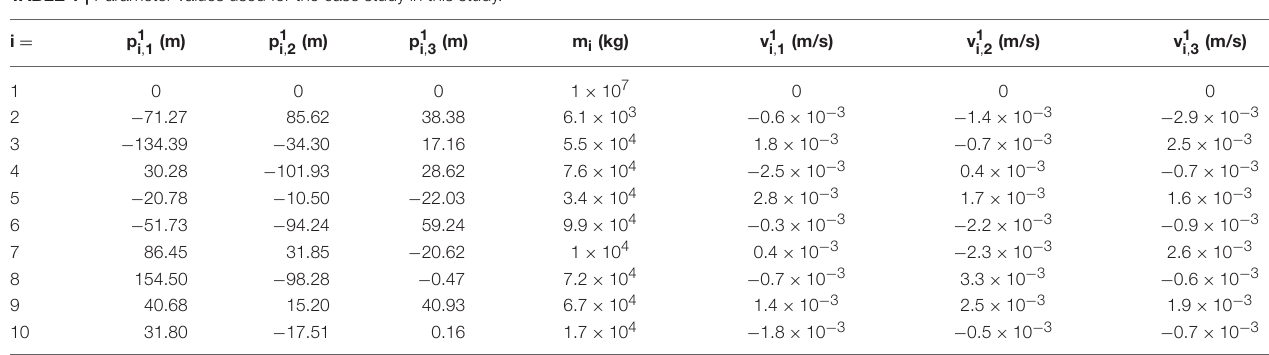
TABLE 1 | Parameter values used for the case study in this